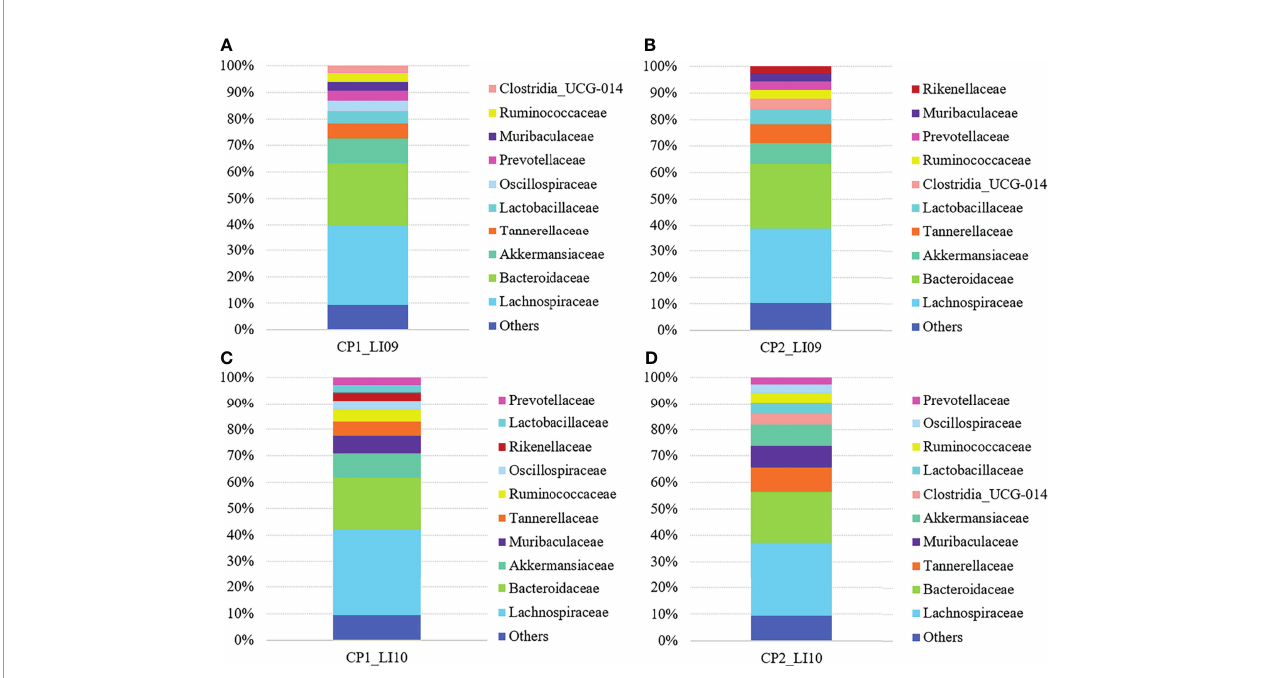
FIGURE 5 | Bacterial family compositions in the LI09 and LI10 cohorts with different cytokine pro fi les, i.e., (A) CP1_LI09, (B) CP2_LI09, (C) CP1_LI10 and (D) CP2_LI10